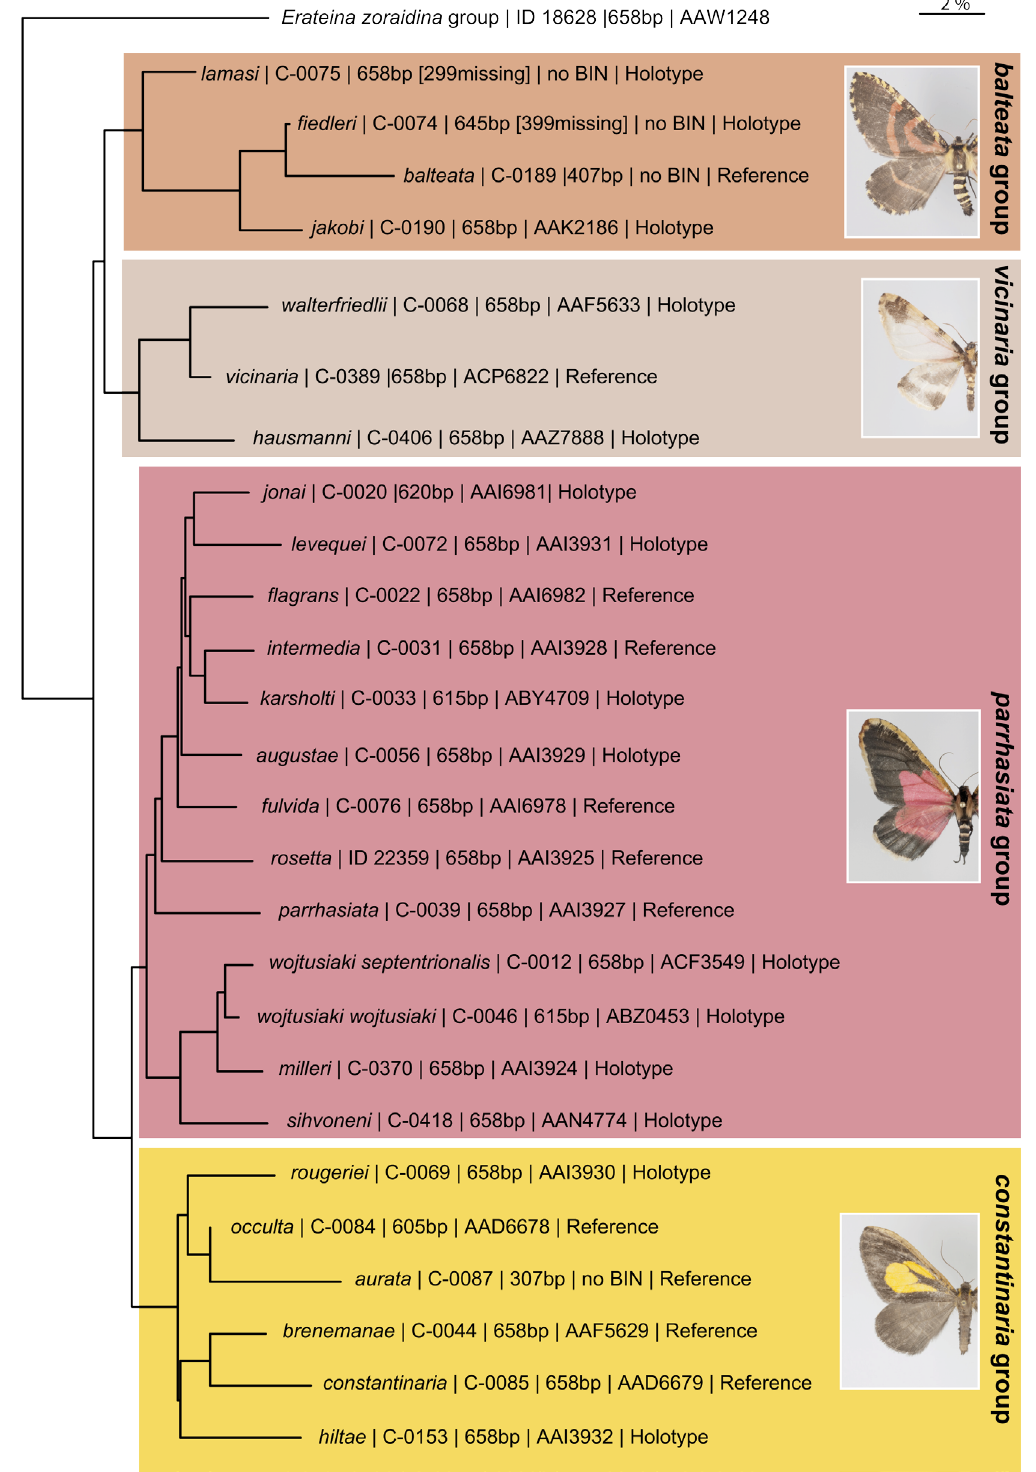
Fig. 1. Summary tree of the available molecular genetic data based on genetic COI barcodes using the Kimura 2 parameter implemented in BOLD systems. All valid species with the exception of Callipia paradisea Thierry-Mieg, 1904 are represented by the barcode data, either by type specimens or as reference specimens. The species name is followed by the individual identification number and the Barcode Index Number (BIN). A full tree is available in the supplementary material (Supplementary File